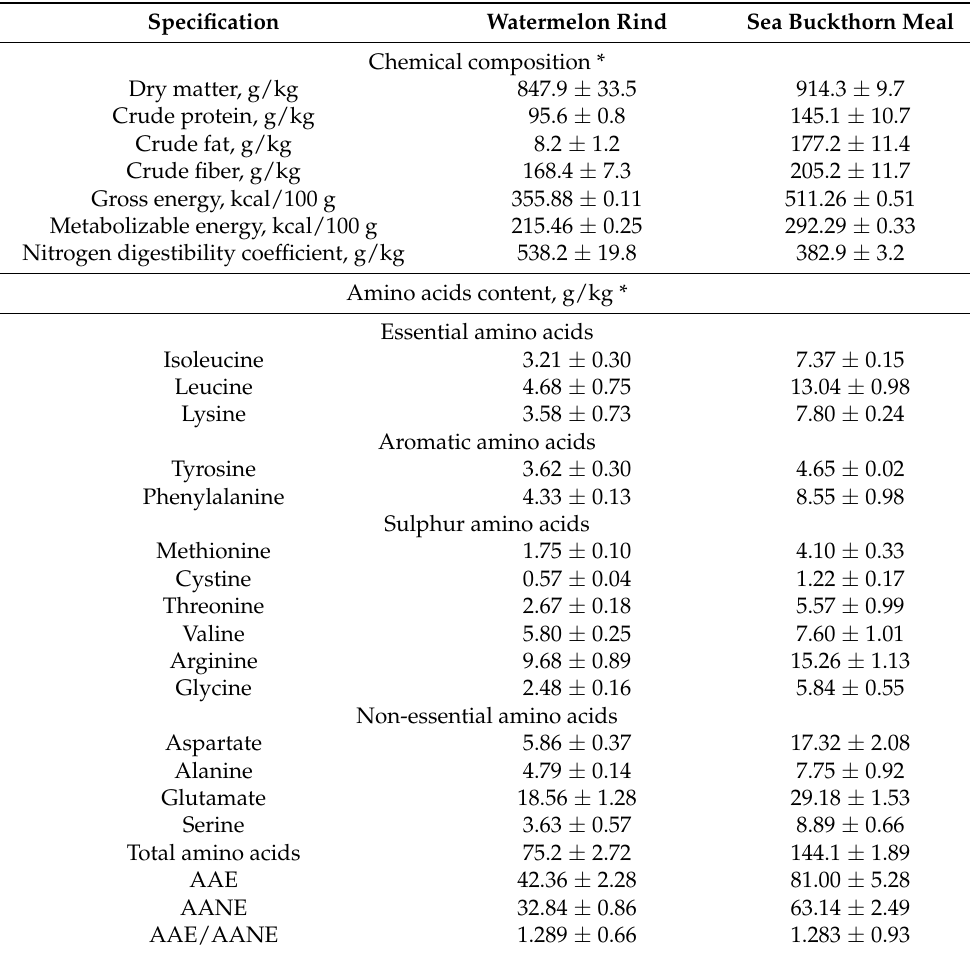
Table 3. Chemical composition of watermelon rind powder and sea buckthorn